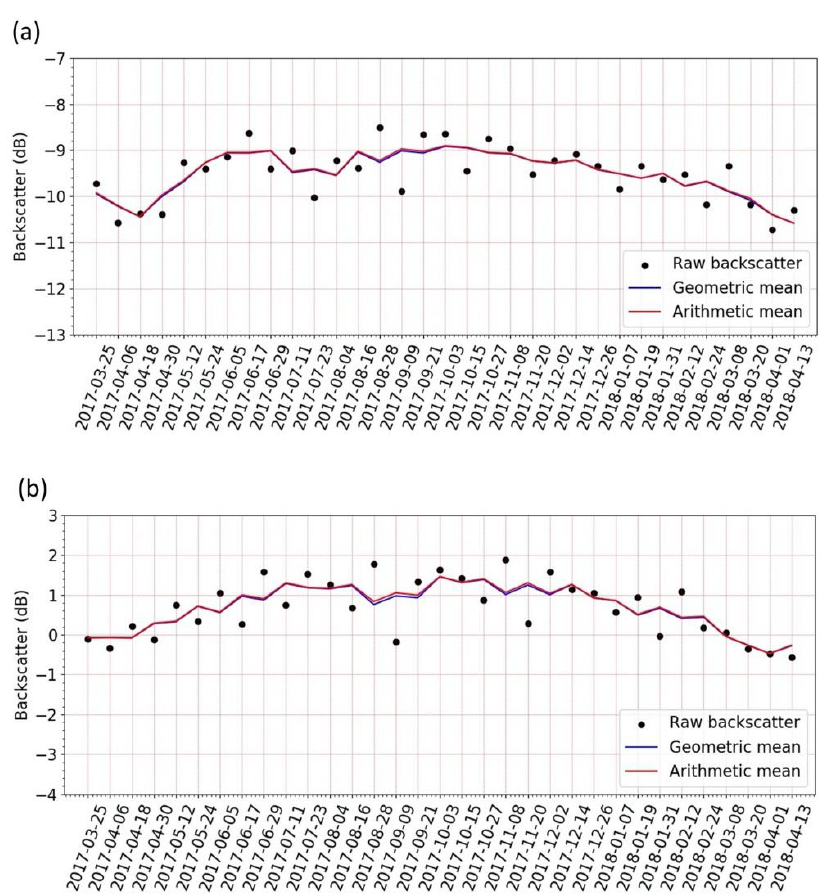
Figure 2. Example of filtering of raw Sentinel-1A SAR time series for ( a ) VH and ( b ) VV polarizations over Bạc Liêu city.